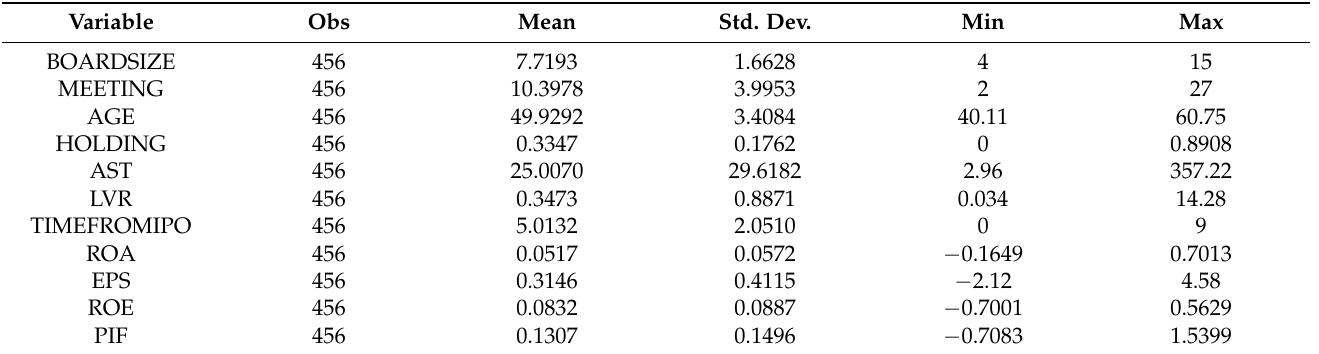
Table 2. Summary statistics.